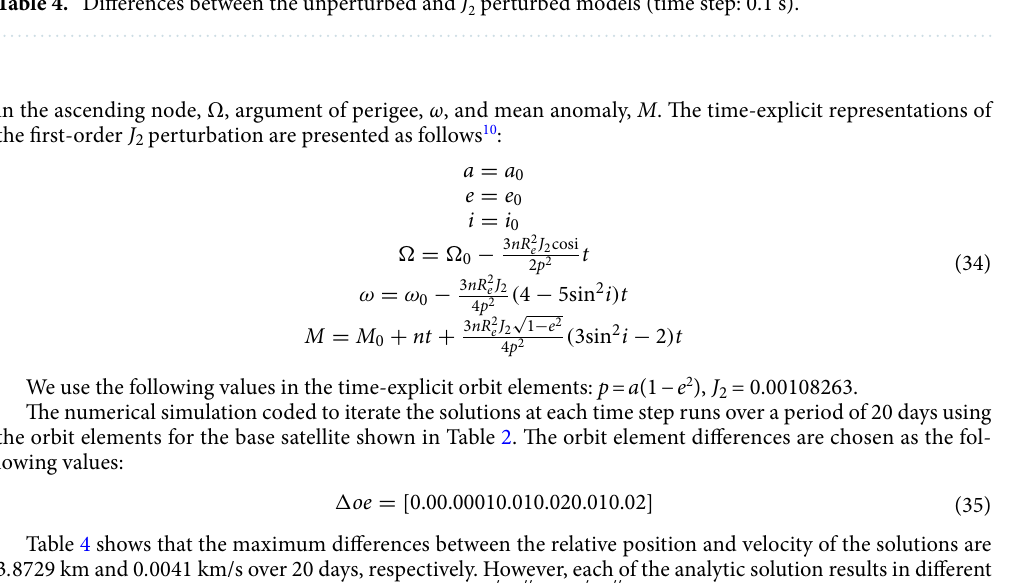
Table 4. Differences between the unperturbed and J 2 perturbed models (time step: 0.1